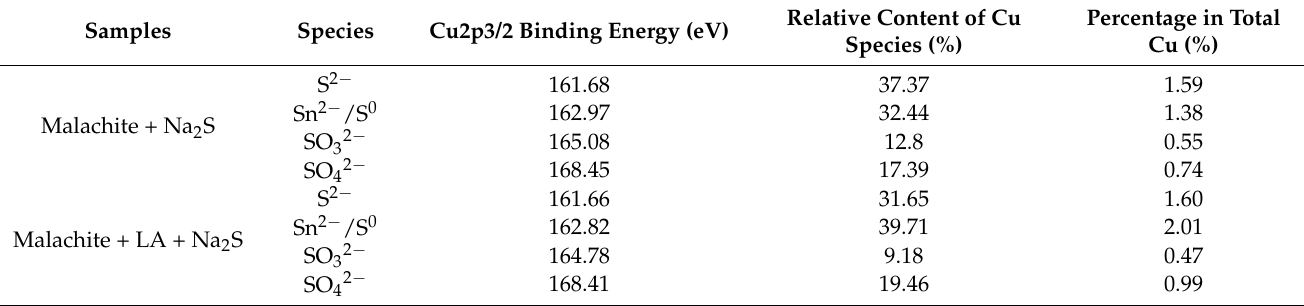
Table 4. Contents and percentages of different S species in total S on the malachite